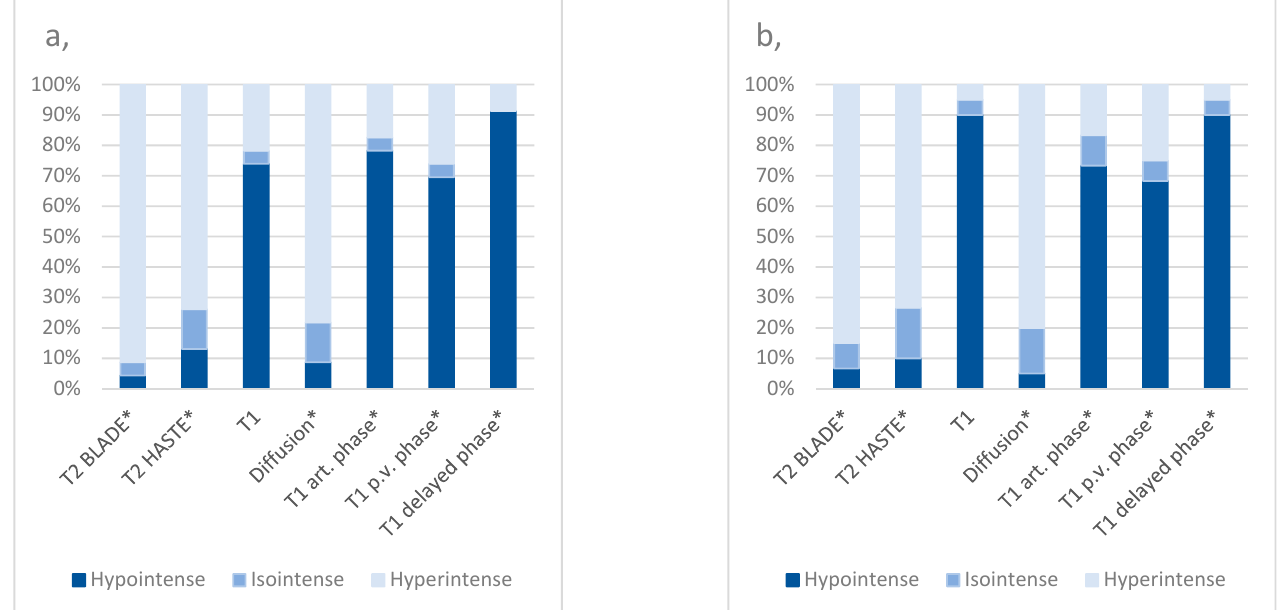
Figure 3. Proportions of signal characteristics in the peripheral ablation zone of patients suffering from a local tumor progression after IRE of an HCC ( a ) and of the reference group ( b ) * = contrast-enhanced; art. phase = arterial phase; p.v. phase = portal venous phase. Table 5. Diagnostic accuracy of MRI signal characteristics for a local tumor progression in the pe- ripheral part of the ablation area after IRE of an HCC.